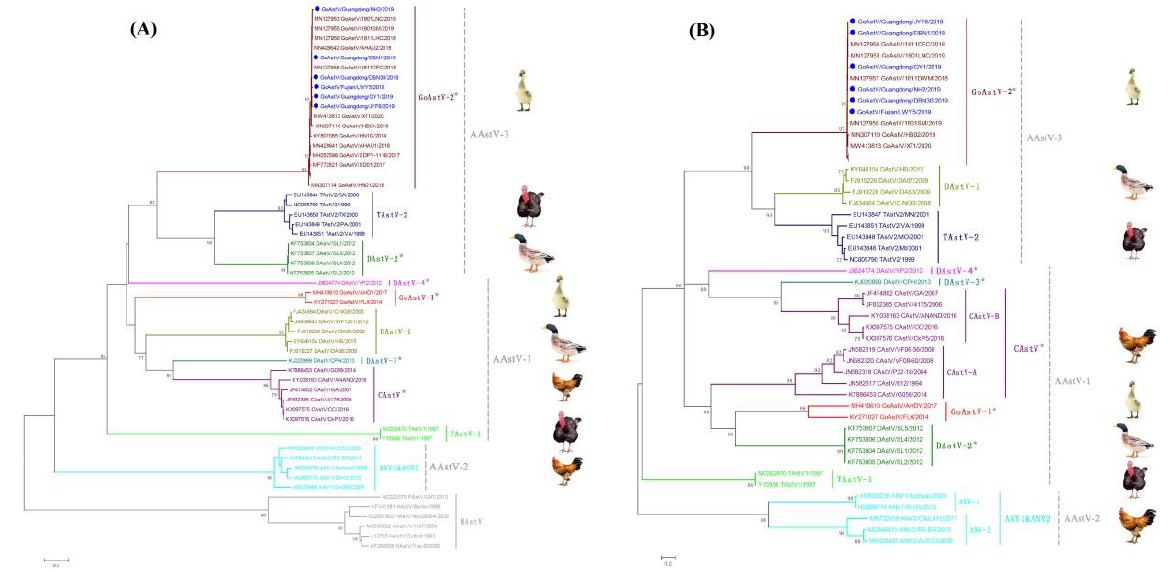
Figure 3. Phylogenetic analysis of the GoAstV with other astroviruses constructed based on the RdRp and Cap genes. ( A ) Phylogenetic tree of astroviruses constructed by using the RdRp gene (1551 bp) and ( B ) phylogenetic tree of astroviruses constructed by using the Cap gene (2115 bp). The strains shown in blue with solid blue circles were identified in this study, and proposed species yet to be recognized are designated with asterisks.